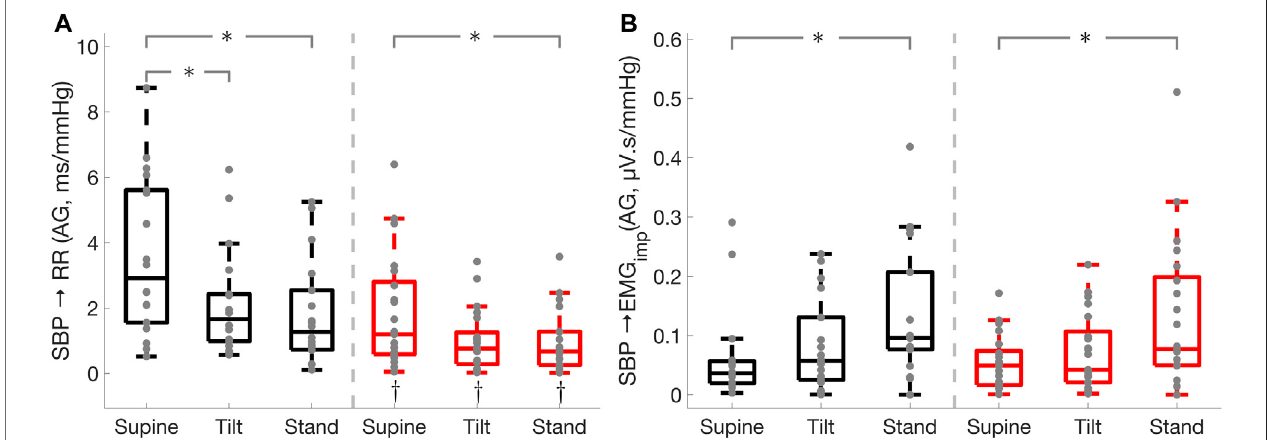
FIGURE 2 | Effect of Parkinson ’ s disease on the effectiveness of the cardiac barore fl ex and cardio-postural coupling. Cardiac barore fl ex active gain (A) , cardio- postural coupling active gain (B) . * illustrates a signi fi cance difference for multiple comparison (post-hoc analysis with Bonferroni adjustment) between supine, tilt, and standing in Parkinson ’ s disease patients (red) and healthy controls (black), while † represents a signi fi cant difference (Wilcoxon rank sum test) between Parkinson ’ s disease patients and healthy controls.